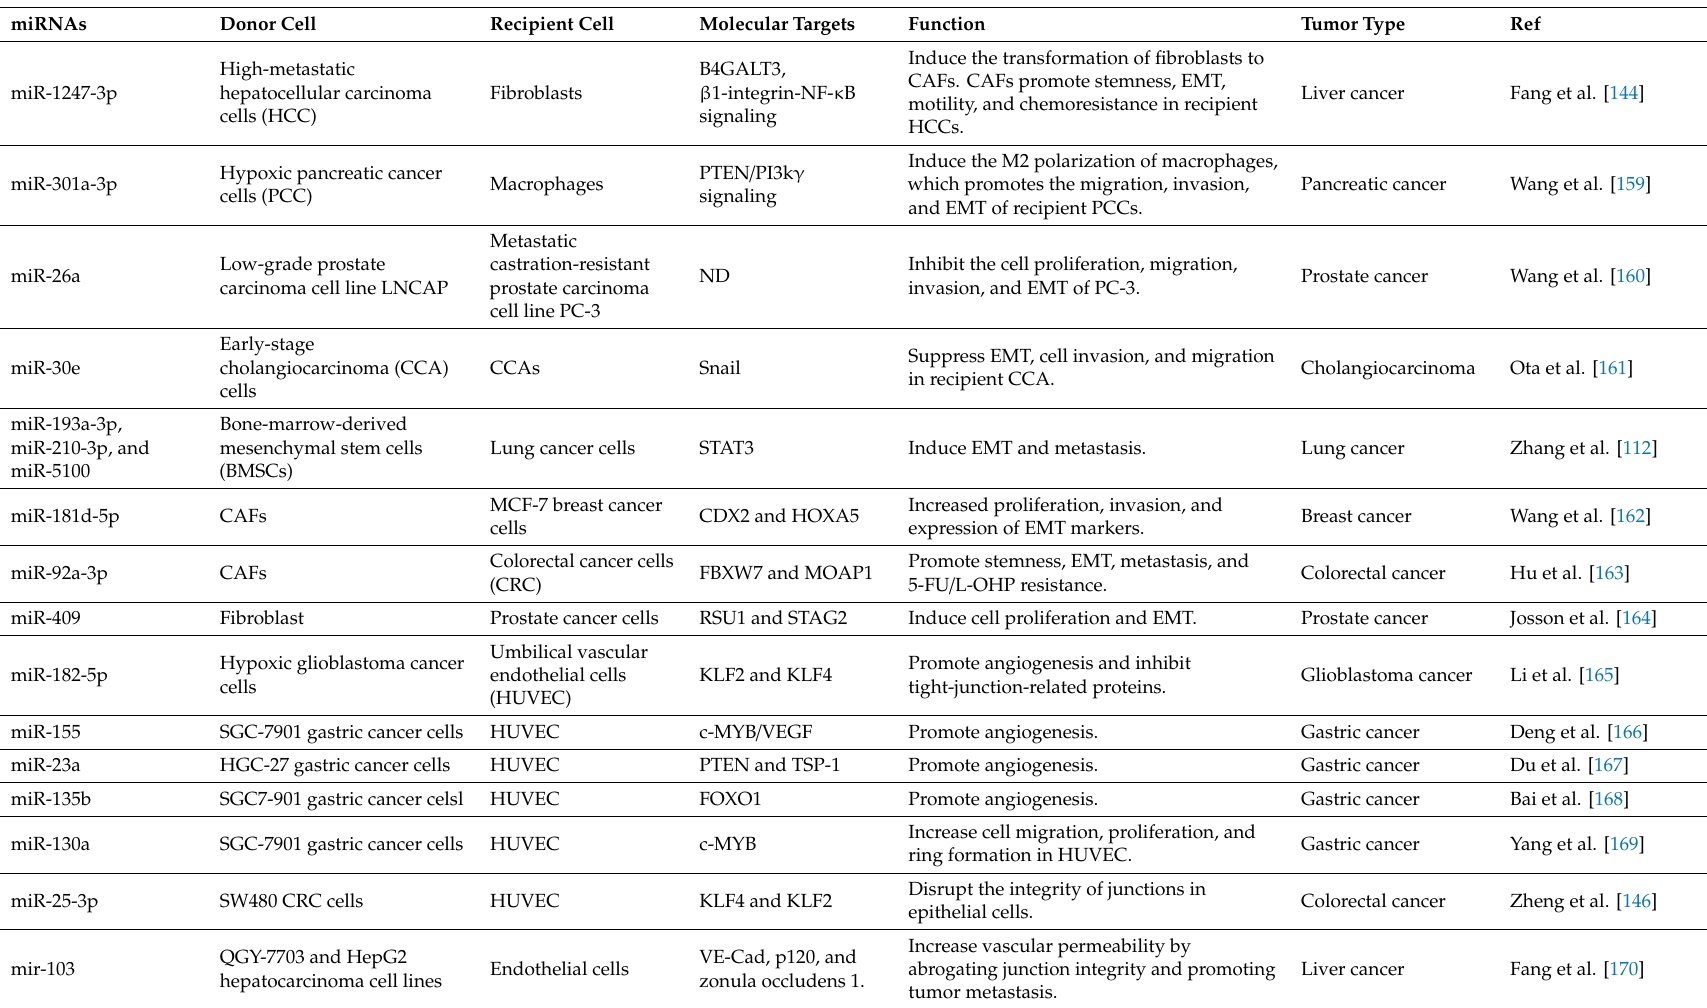
Table 1. Extracellular miRNAs in the mechanisms of tumor development and